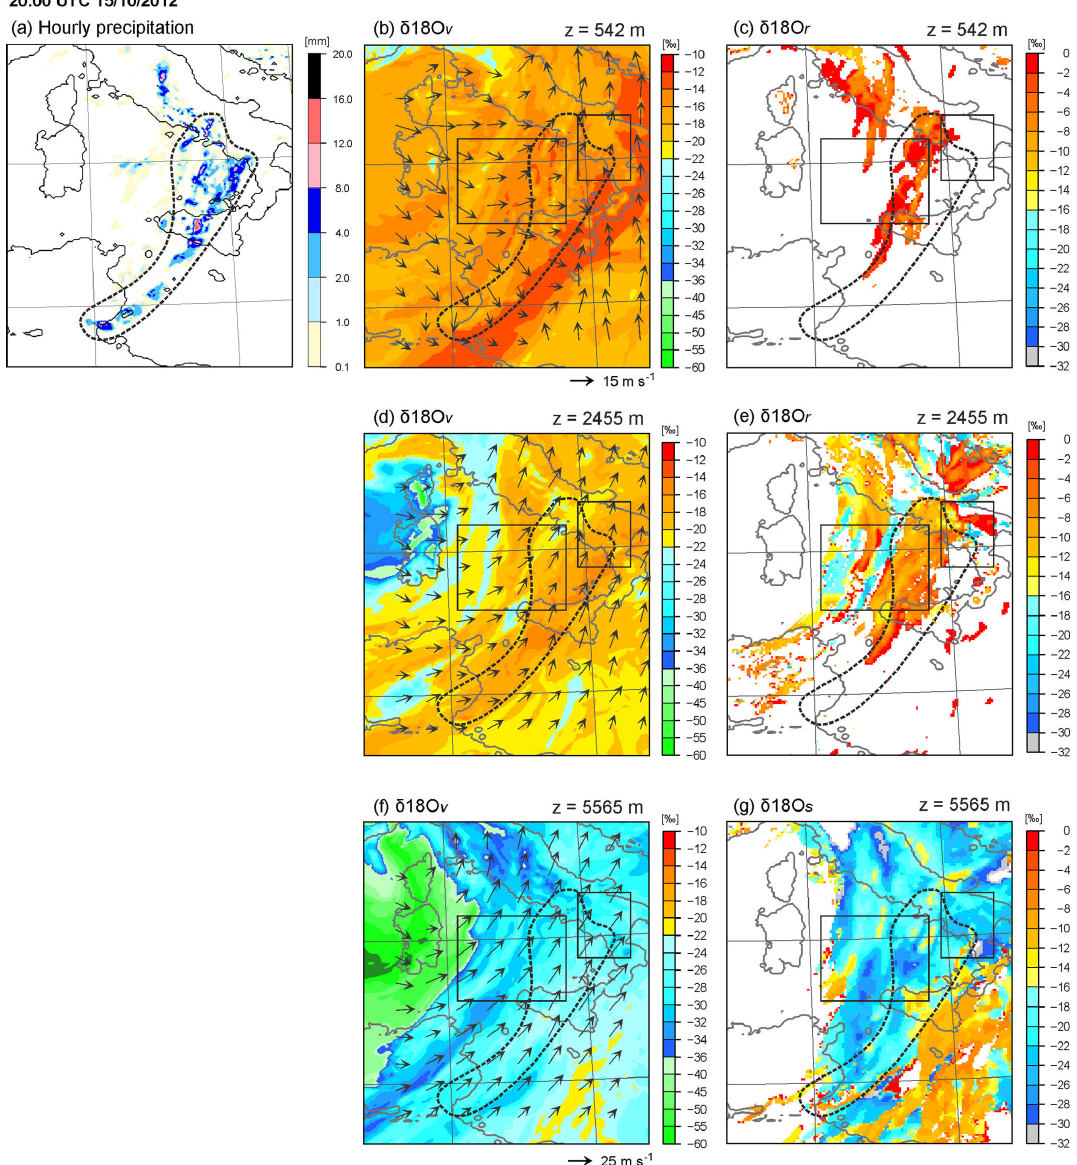
Figure 10. Horizontal distributions of (a) surface hourly precipitation (mm), δ 18 O v (‰), at (b) model level 8 (about 542ma.s.l.), (c) model level 16 (about 2455ma.s.l.), and (d) model level 23 (about 5565ma.s.l.), δ 18 O r (‰) at (e) 542ma.s.l. and (f) 2455ma.s.l., and δ 18 O s (‰) at 5565ma.s.l. at 20:00UTC on 15 October 2012. Note that due to the terrain-following coordinates, the SWI values are partly depleted over the topography, e.g. in central Italy. The precipitating area is marked by the area enclosed by the dashed